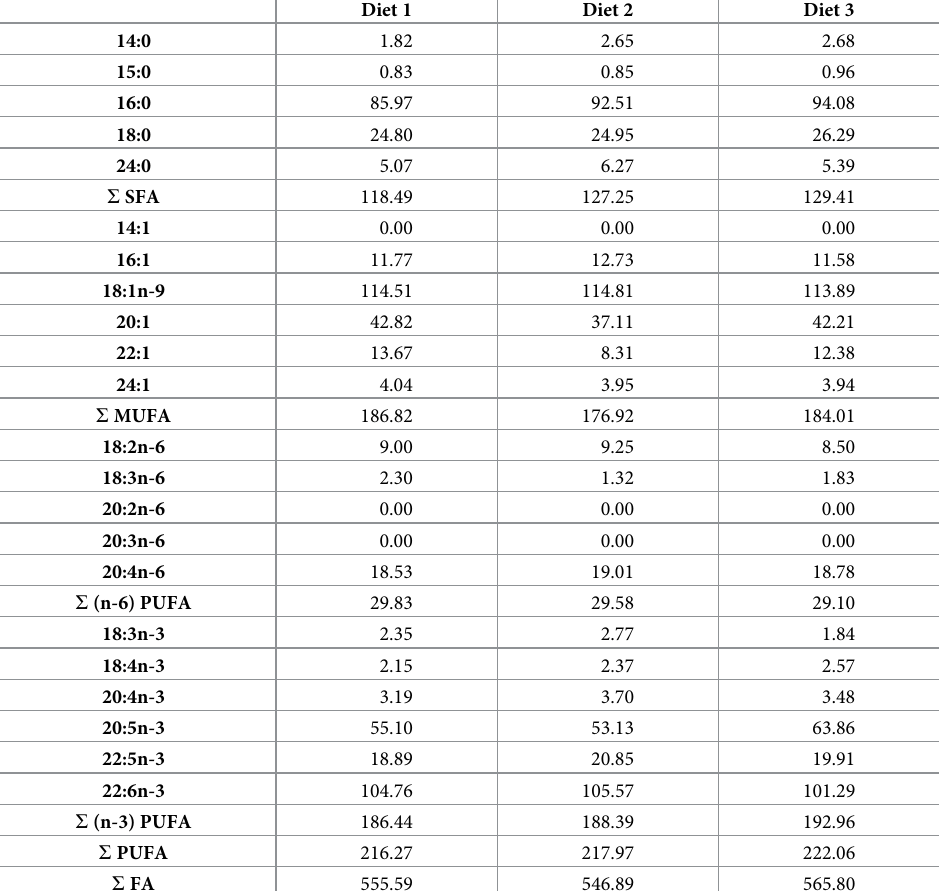
From 10 dph and onwards, dead larvae were counted and removed daily from all experimental units ( n = 9 ). Larval cumulative mortality was calculated as a percentage from 10 until 28 dph. Larvae sampled throughout the experimental period were not considered for further calculation. Subsamples ( n = 3) of 10 larvae each were collected at hatch (0 dph) and larvae Table 2. Fatty acids of three experimental diets applied as feeds for larvae of European eel, Anguilla anguilla . Diet 1 Diet 2 Diet 3